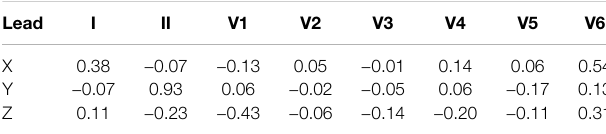
TABLE 2 | Transformation coef fi cients of Kors regression method.